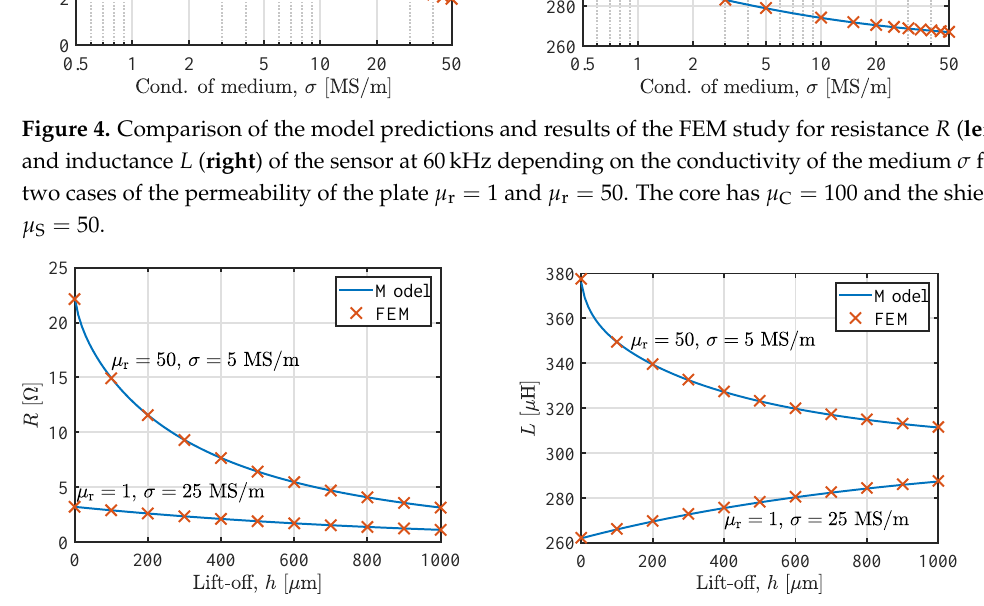
Figure 5. Comparison of the model predictions and results of the FEM study for resistance R ( left ) and inductance L ( right ) of the sensor at 60kHz depending on the lift-off h for two plates: µ r = 1 and σ = 25MS/m, and µ r = 50 and σ = 5MS/m. The core has µ C = 100 and the shield µ S =